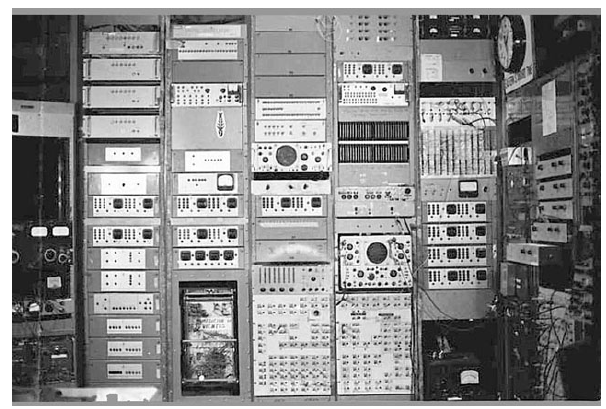
Figure 15. The digital correlator at Jicamarca, which was an elec- tronic system that was used to compute the correlation of the IS signals measured by the radar (picture provided by Jorge